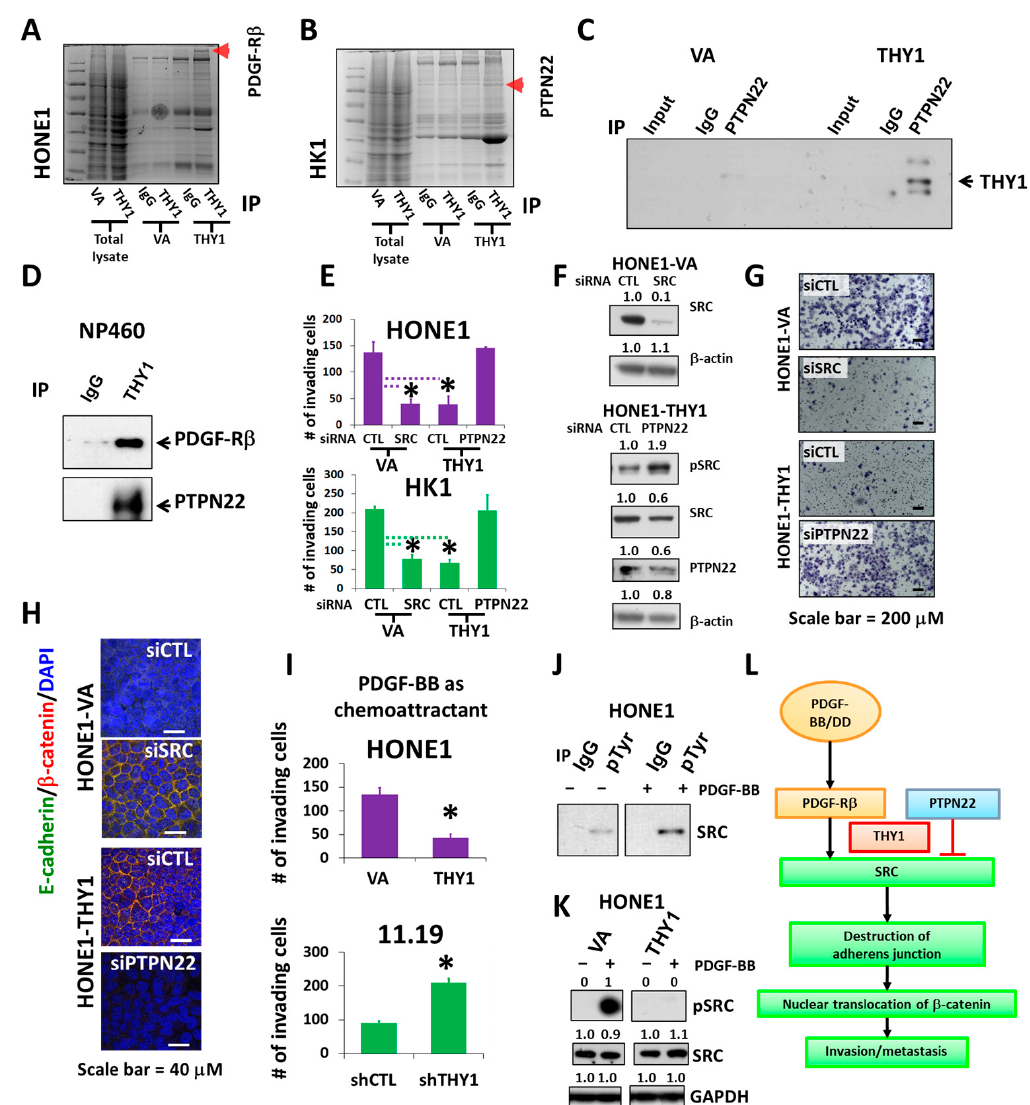
Figure 4. PTPN22 is essential for THY1 to inhibit SRC activation. Coomassie staining of immunoprecipitated and total lysates of cell lines as indicated. Arrows indicate ( A ) PDGF-R β and ( B ) PTPN22, identified by mass spectrometry and validated with co-IP. The interaction of THY1 with PDGF-R β and PTPN22 were verified with co-IP analysis in HK1 cells in ( C ), and NP460 cells in ( D ). ( E ) Chamber invasion assay for SRC and PTPN22 siRNA depletion in HONE1-VA, HONE1-THY1, HK1-VA, and HK1-THY1 cells. *: p < 0.05. ( F ) Western blot analysis of SRC and PTPN22 in siRNA knockdown cells. ( G ) Representative images of the invaded HONE1-VA and HONE1-THY1 cells with SRC or PTPN22 knockdown. ( H ) IF staining of adherens junctions (merged images of green E-cadherin and red β -catenin) for cell lines described in Figure 4G. ( I ) Chamber invasion assay using PDGF- BB as a chemoattractant for HONE1-VA and HONE1-THY1 cells, HK11.19 and THY1-knockdown HK11.19 cells. *: p < 0.05. ( J ) Co-IP analysis of phospho-SRC in the presence of PDGF-BB in HONE1. ( K ) Western blot analysis of pSRC (Y419) and total SRC in THY1-expressing cells in response to PDGF-BB. ( L ) Schematic illustration of how THY1 can regulate EMT and SRC activity through the interaction with PTPN22 and PDGF-R β